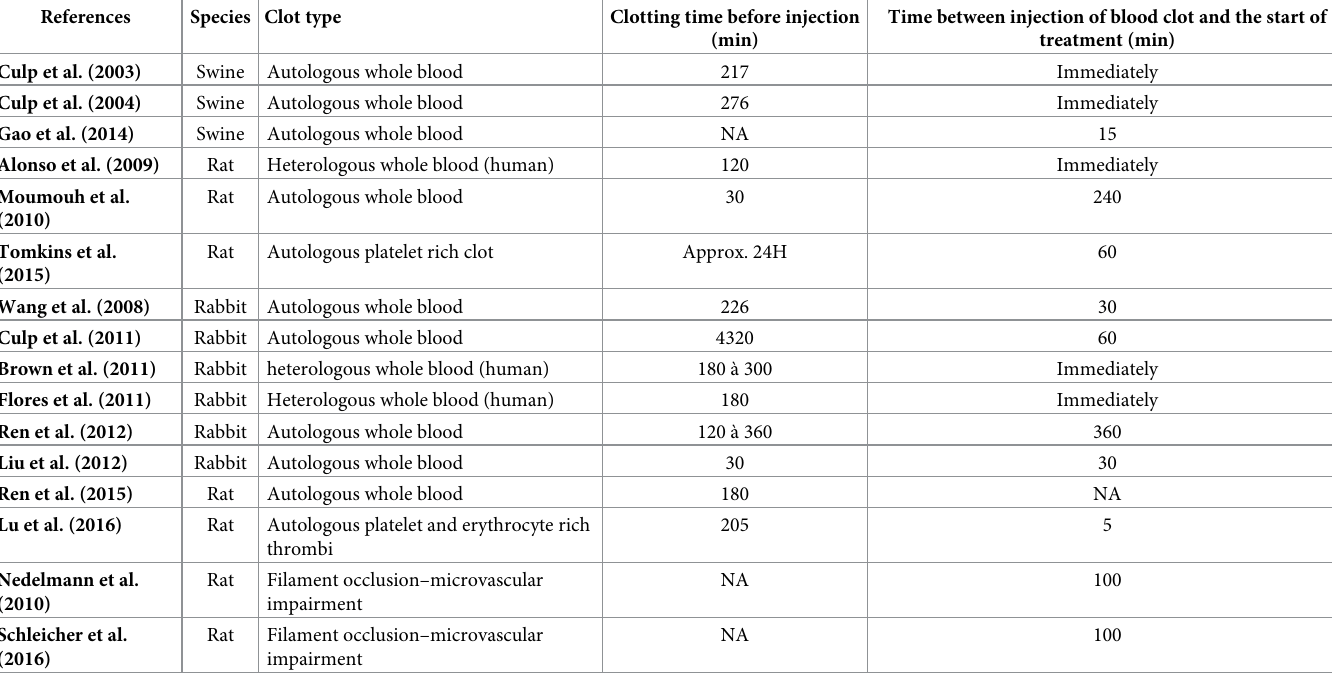
Table 3. Summary of compositions of various clots, clotting time before injection, and time between injection and the start of